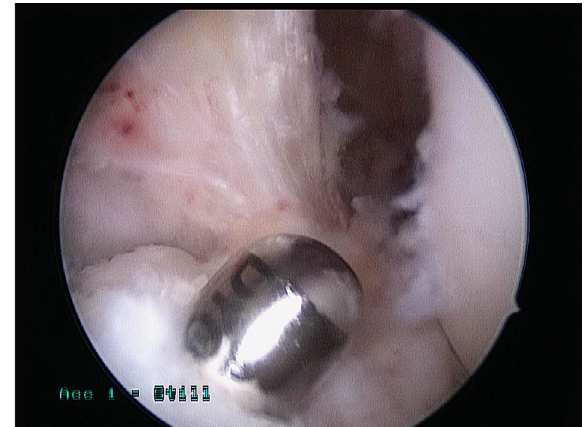
Figure 3. Debridement of debris from the tibial